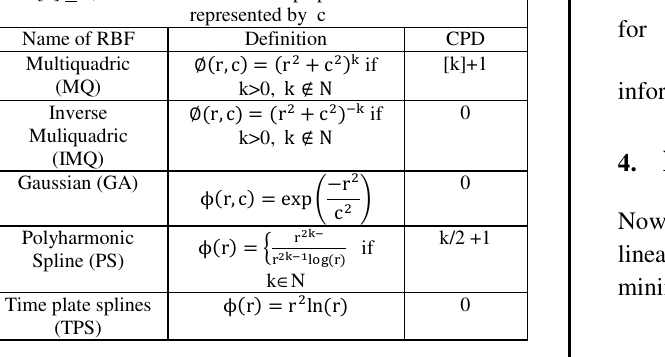
is represented by c. Table 1: List of RBFs, where k shows the k-order CPD [27], [k] < k, n is natural number. shape parameter in RBF is represented by c Name of